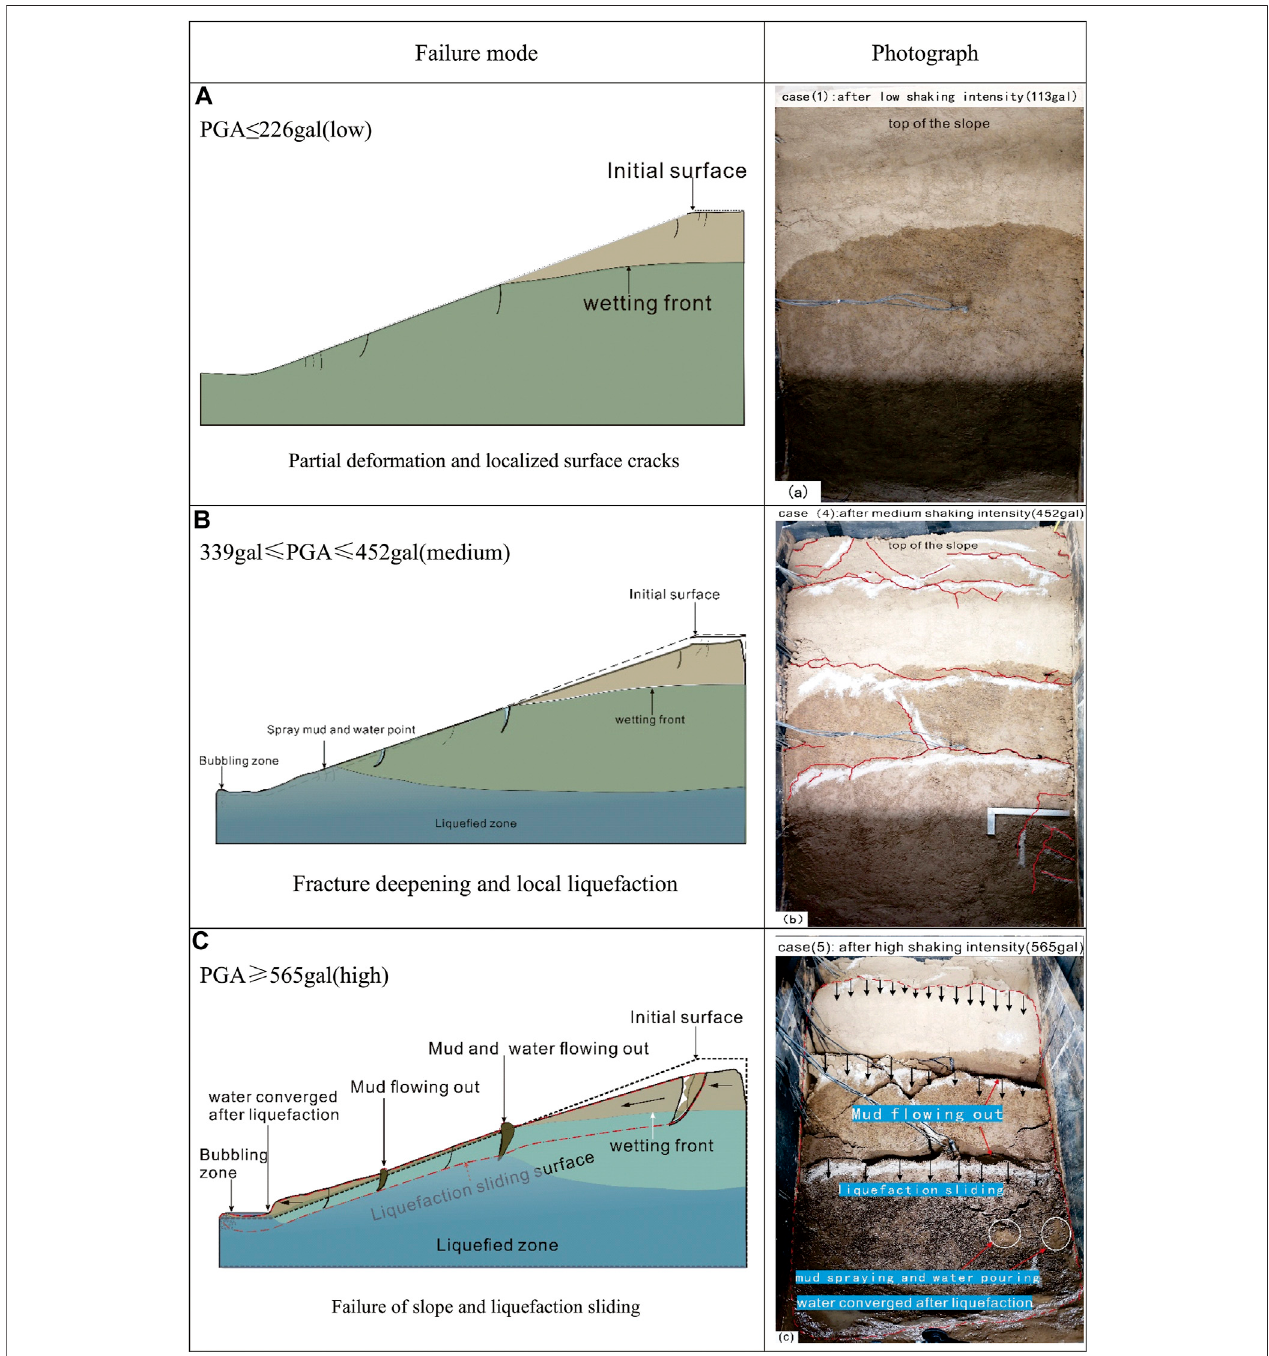
FIGURE 9 | Summarized failure modes: (A) low shaking intensity (113 gal); (B) medium shaking intensity (452 gal); (C) high shaking intensity (565 gal).